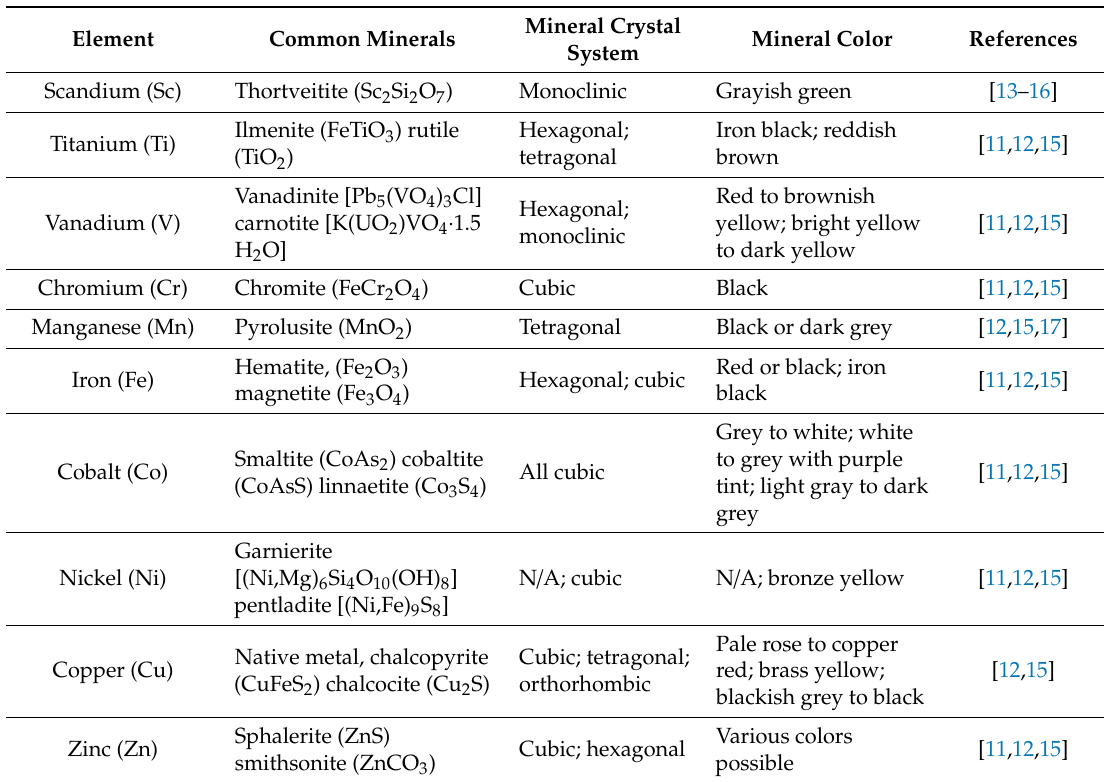
Table 1. Common minerals of first-row transition